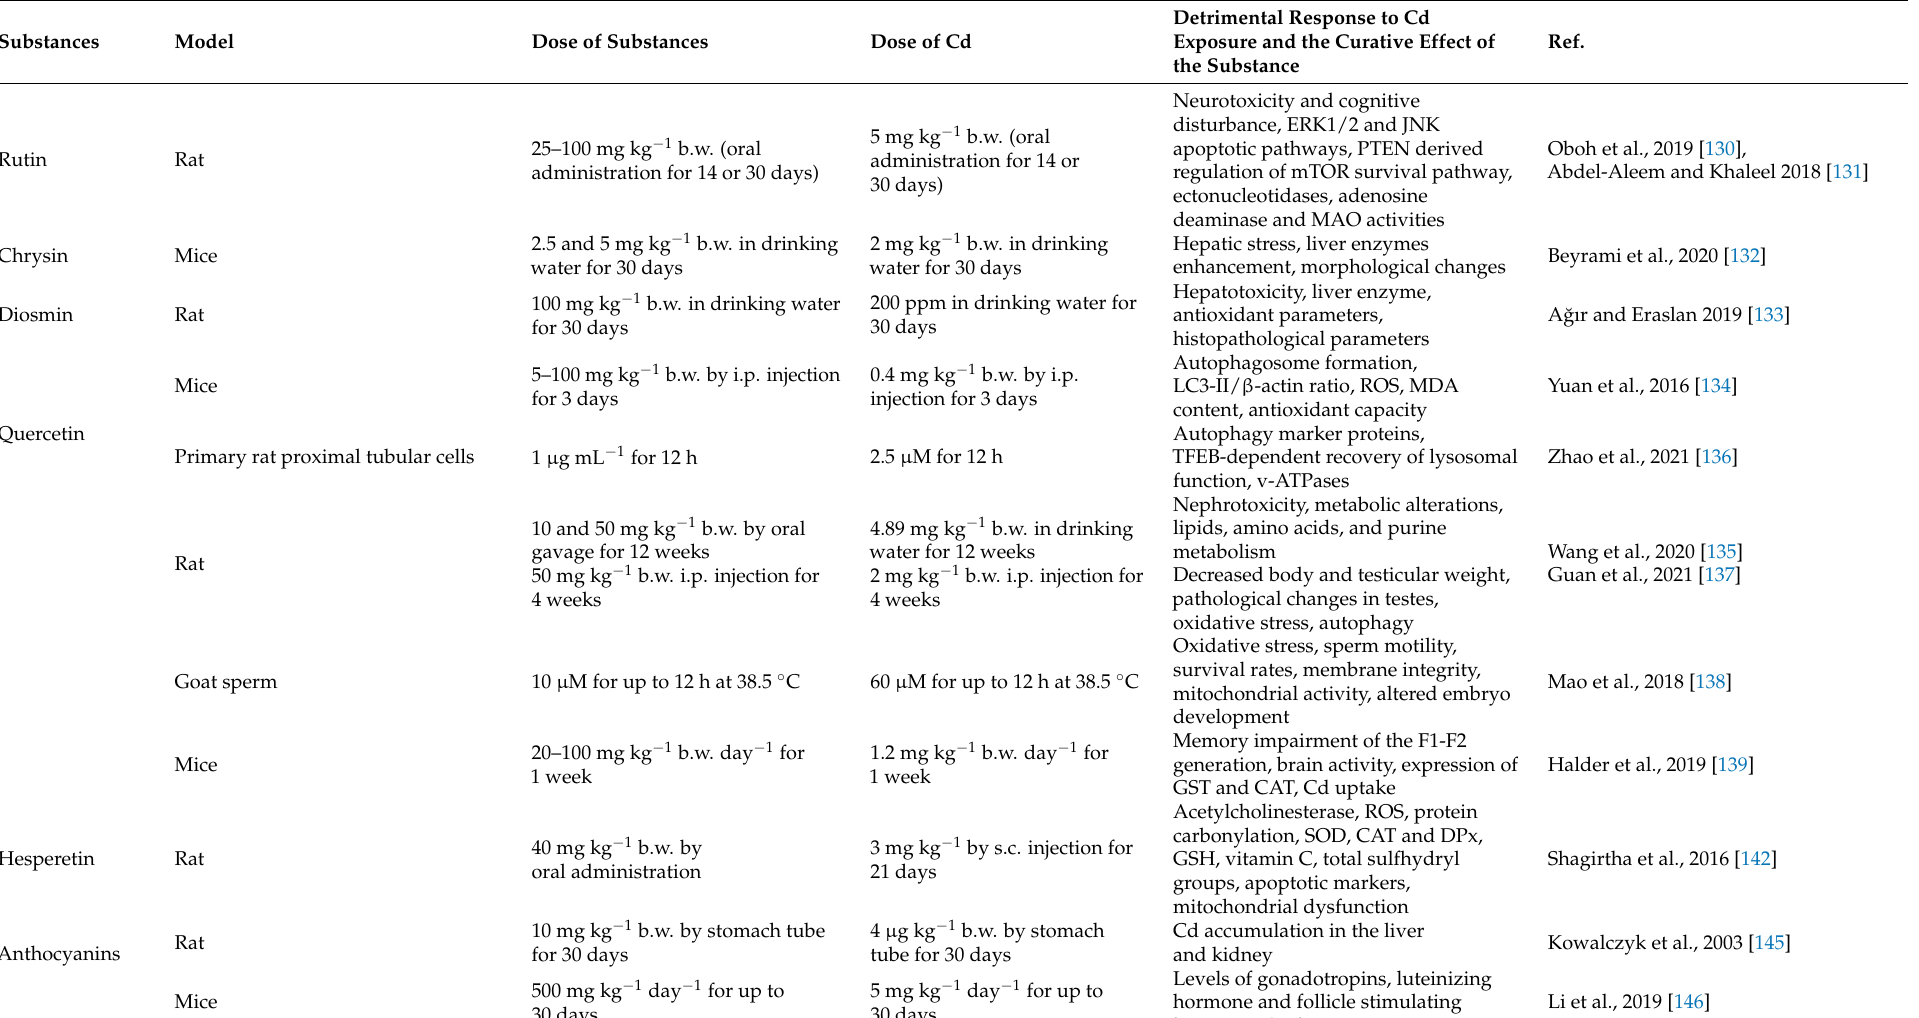
Table 3. Effect of bioactive